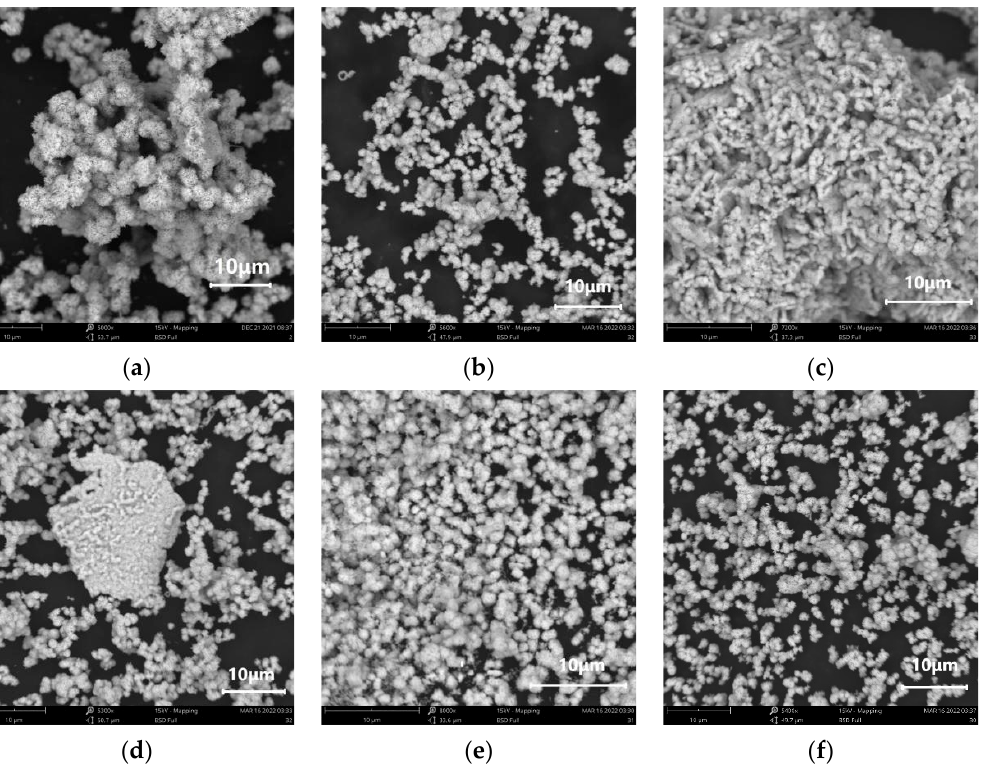
Figure 3. SnO 2 morphology at 200 °C, with 50 mg PVP, V = 1:1, and reacting for ( a ) 48, ( b ) 36, ( c ) 30, ( d ) 24, ( e ) 18, and ( f ) 12 h.